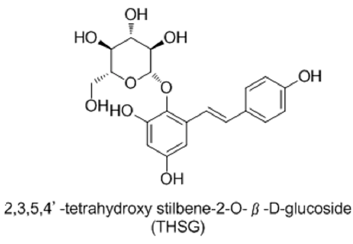
Figure 28. Structure of THSG isolated from dried tuber root of Polygonum multiflorum .